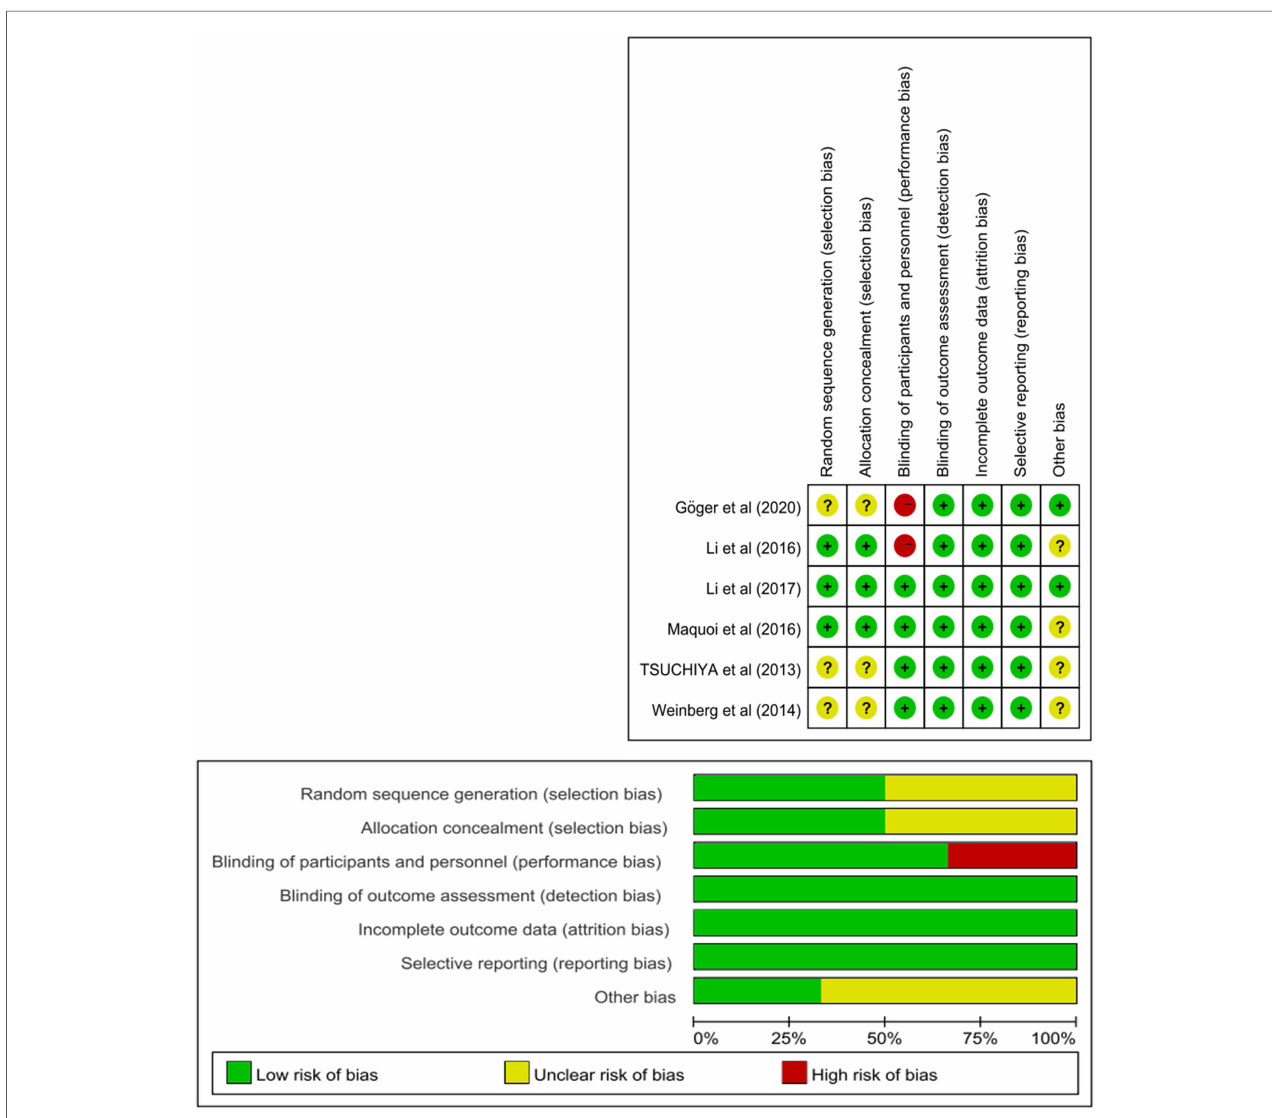
FIGURE 2 Risk of bias summary and graph of the included